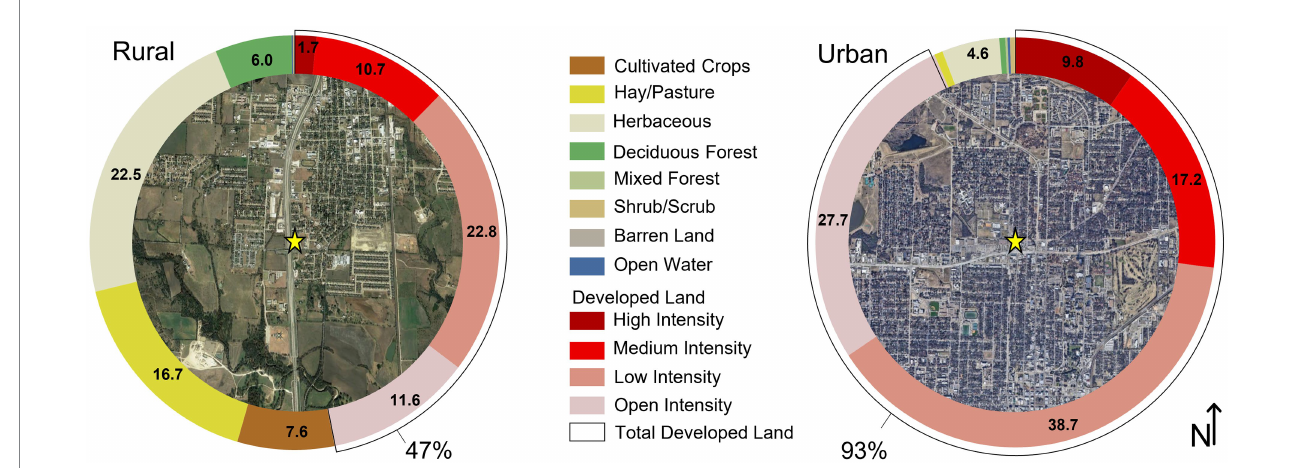
FIGURE 1 2016 Land cover (Yang et al., 2018; Jin et al., 2019; Homer et al., 2020) within 2 km of sampled pigeon populations in Denton County. Image sources: “Rural, Sanger, Texas.” 33